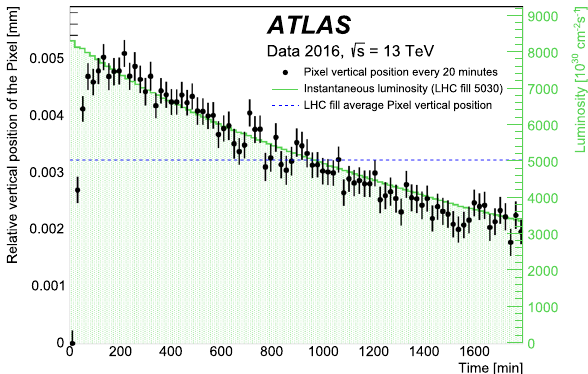
Fig. 8 The Pixel detector vertical ( T y ) movement as a function of the time since the start of an LHC fill. The average Pixel T y for the entire run (dashed blue line) is compared with its time evolution and with the instantaneous LHC luminosity. The error bars represent the statistical